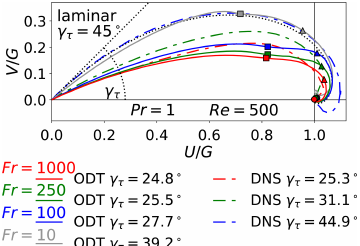
Figure 9. Hodographs of the ensemble-averaged horizontal veloc- ity ( U,V, 0) T at t − = 1. ODT results (thin solid lines) are shown to- gether with corresponding reference DNS (thick broken lines) from Ansorge and Mellado (2014). The wall-shear angle γ τ ∈ [ 0 , 45 ◦ ] represents the opening angle of the Ekman spiral. simulated values of γ τ are explicitly given in the legend for comparison. The lami- nar Ekman spiral (curved dotted line) is characterized by γ τ = 45 ◦ . Single points (symbols) have the same meaning as in Fig. 8.